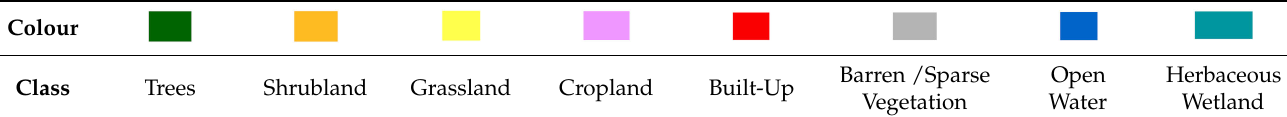
Table 1. WorldCover class colour-coding.